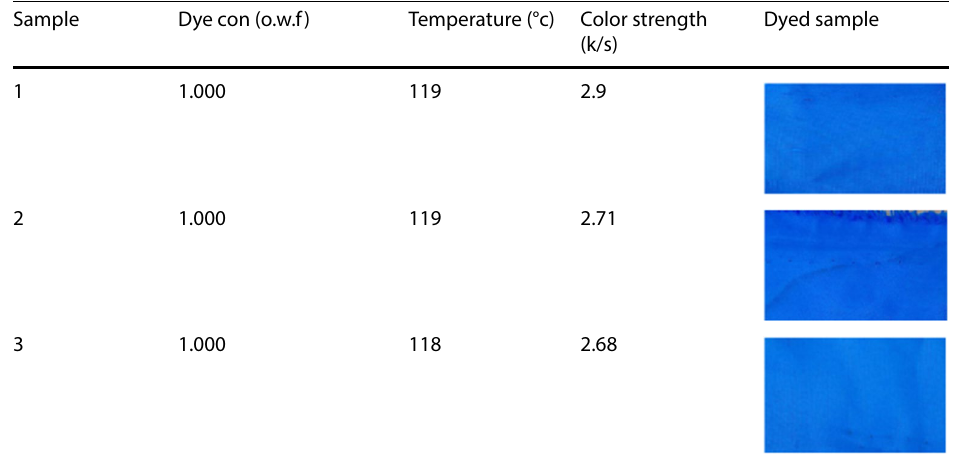
Table 5 Optimized condition for dyeing esterified P/c blend